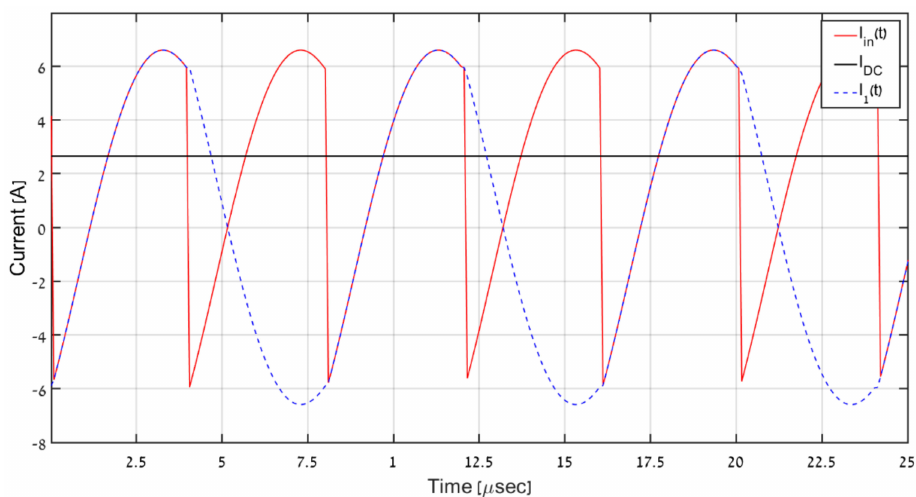
Figure 5. Primary-side current shapes of a LIVO-operating